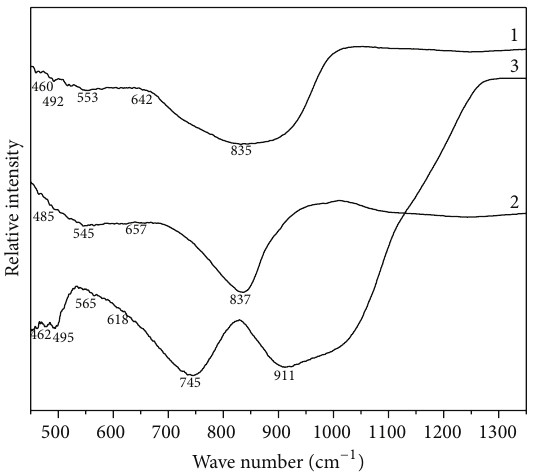
Figure 2: FTIR spectra of Ti 𝑥 O 𝑦 films obtained by DC magnetron sputtering (1: sample deposited during 45min without additional thermal treatment, 2: sample 1 thermally treated at 400 ∘ C, and 3: sample deposited during 7 min and thermally treated at 400 ∘ C).